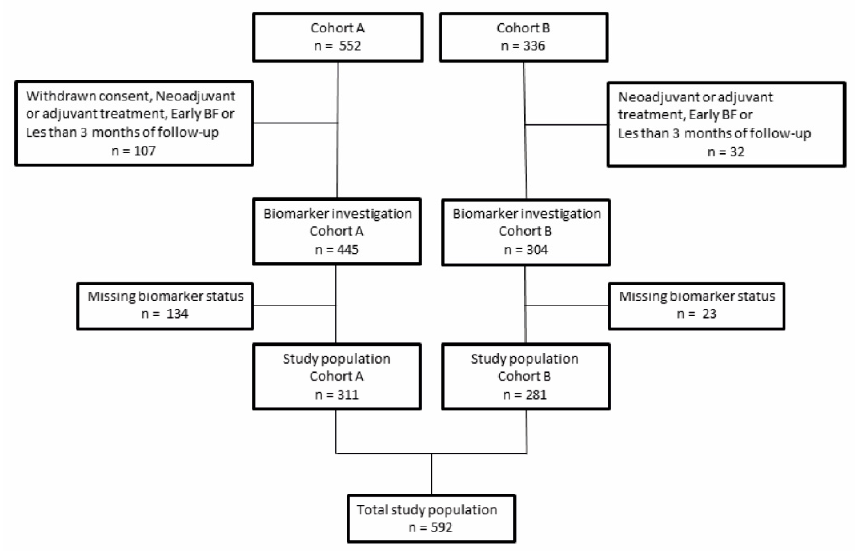
Figure 1. Flowchart of patients who met study inclusion/exclusion